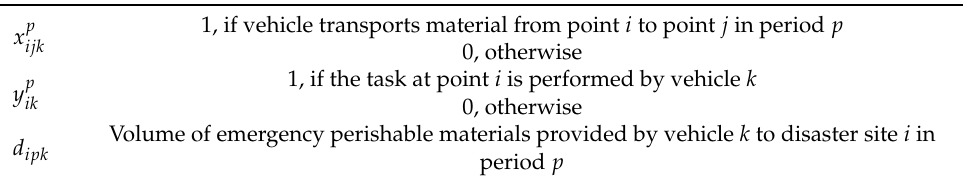
Table 2. Decision